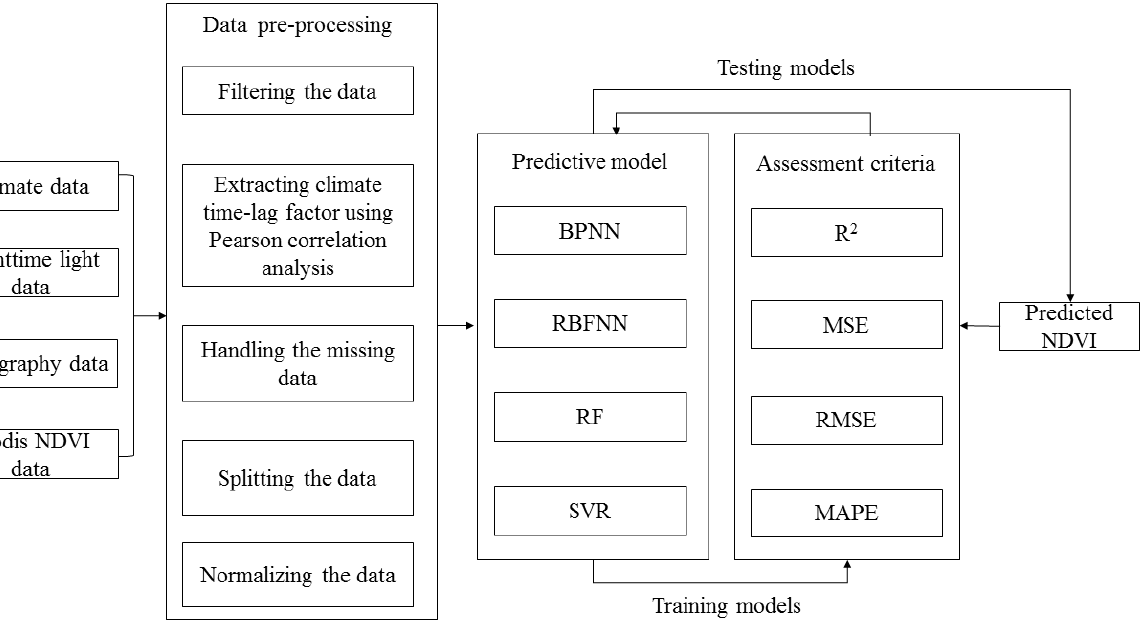
Figure 2. Architecture of the prediction framework using machine learning methods.